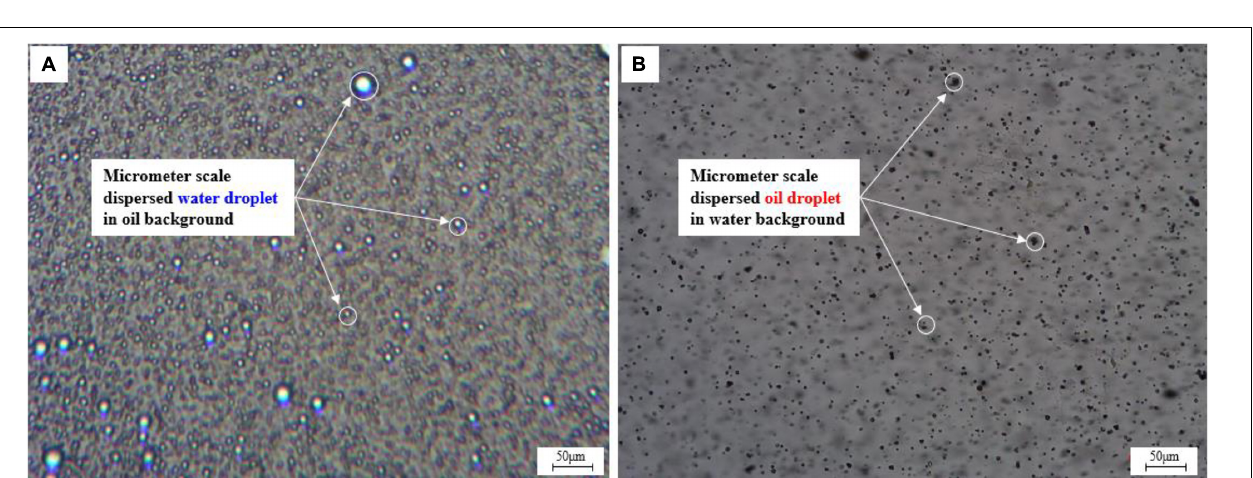
FIGURE 13 | Sandpack flooding test effluents of (A) water in oil emulsion and (B) oil in water emulsion under microscopic